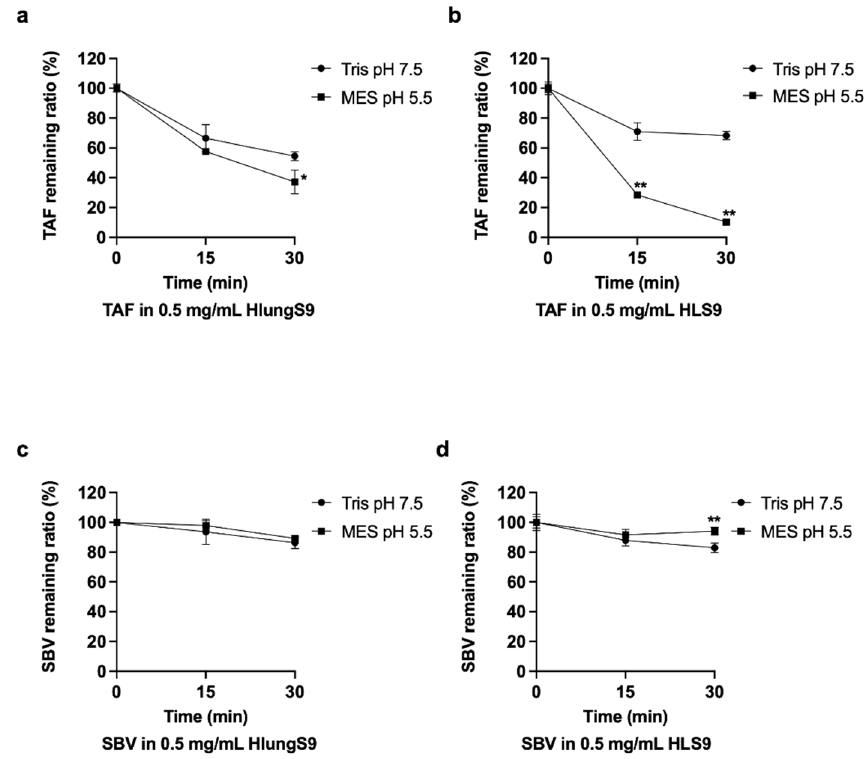
Figure 5. TAF and SBV hydrolysis in HlungS9 and HLS9: 20 μ M TAF were incubated with 0.5 mg/mL HlungS9 ( a ) and HLS9 ( b ) at 37 °C for 15 and 30 min in MES assay buffer (pH 5.5) and Tris buffer (pH7.5); 20 μ M SBV were incubated with 0.5 mg/mL HlungS9 ( c ) and HLS9 ( d ) at 37 °C for 15 and 30 min in MES assay buffer (pH 5.5) and Tris buffer (pH7.5). Data are shown as the remaining TAF or SBV (%) after incubations (mean ± S.D., n = 3, except for SBV with 0.5 mg/mL HlungS9 in MES pH 5.5, where n = 2). * p < 0.05 and ** p < 0.01 vs. the Tris pH 7.5 condition (Student’s t -test).